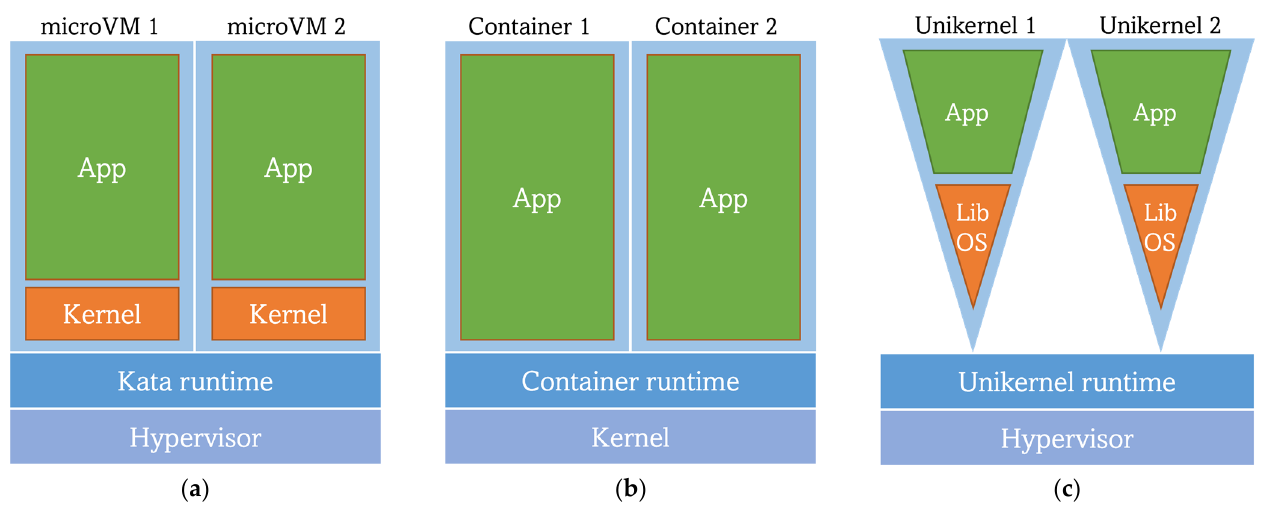
Figure 5. Comparison of the architectures of different virtualization techniques: ( a ) MicroVMs lightweight VM; ( b ) Containers; ( c ) Unikernels.